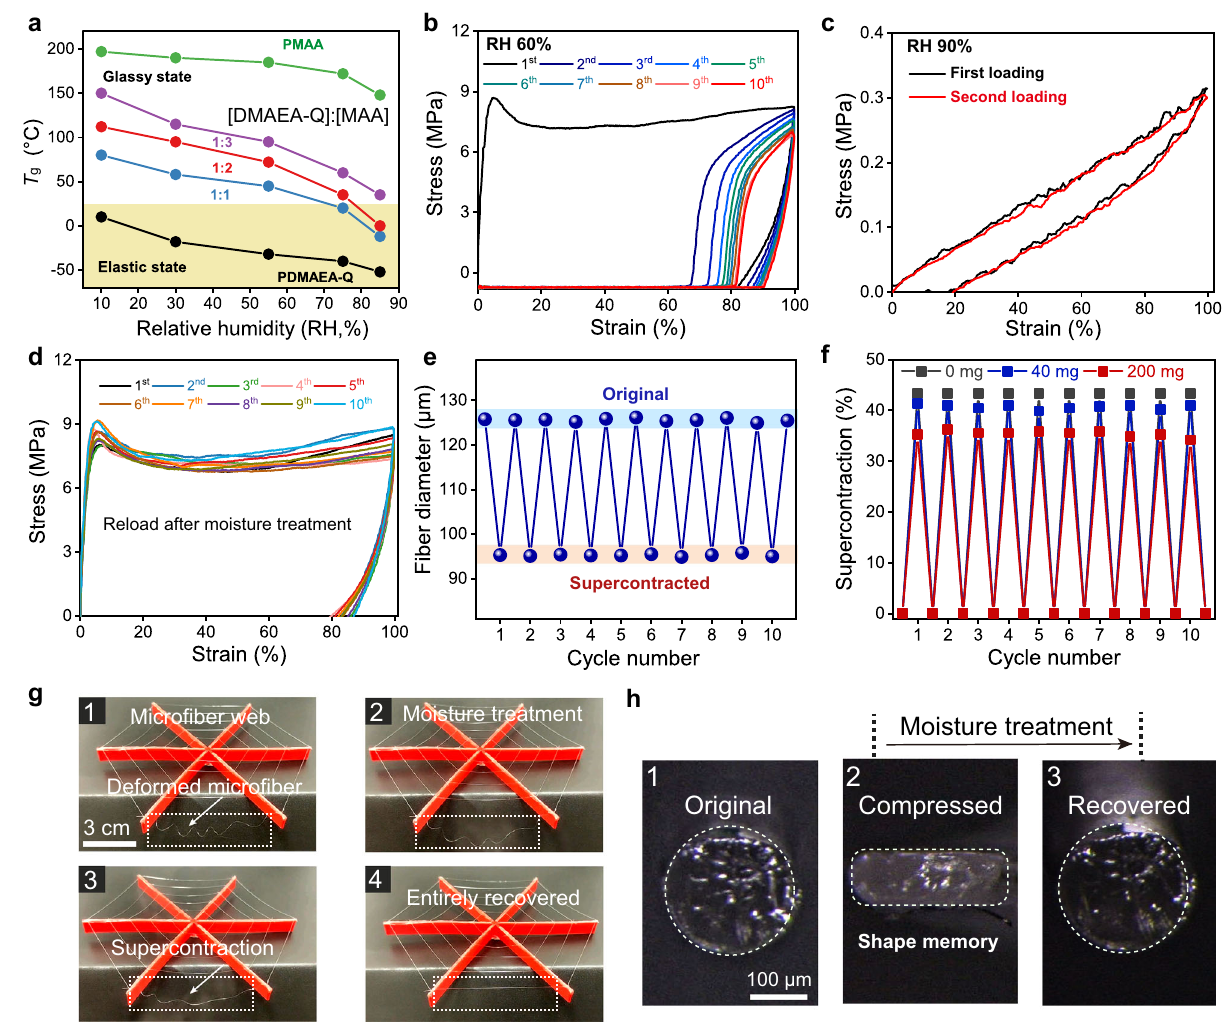
Fig. 5 | Supercontraction and shape-memory properties of PDMAEA-Q/PMAA hydrogel micro fi ber. a Glass transition temperatures ( T g ) with varying DMAEA- Q:MAAmolar ratios and humidities. b Tensileloading-unloading curves atRH 60% for 10 cycles (waiting time = 0s). c Loading-unloading curves at RH 90% for two cycles(waiting time = 30s). d Loading-unloading curves atRH 60%for10cycles of